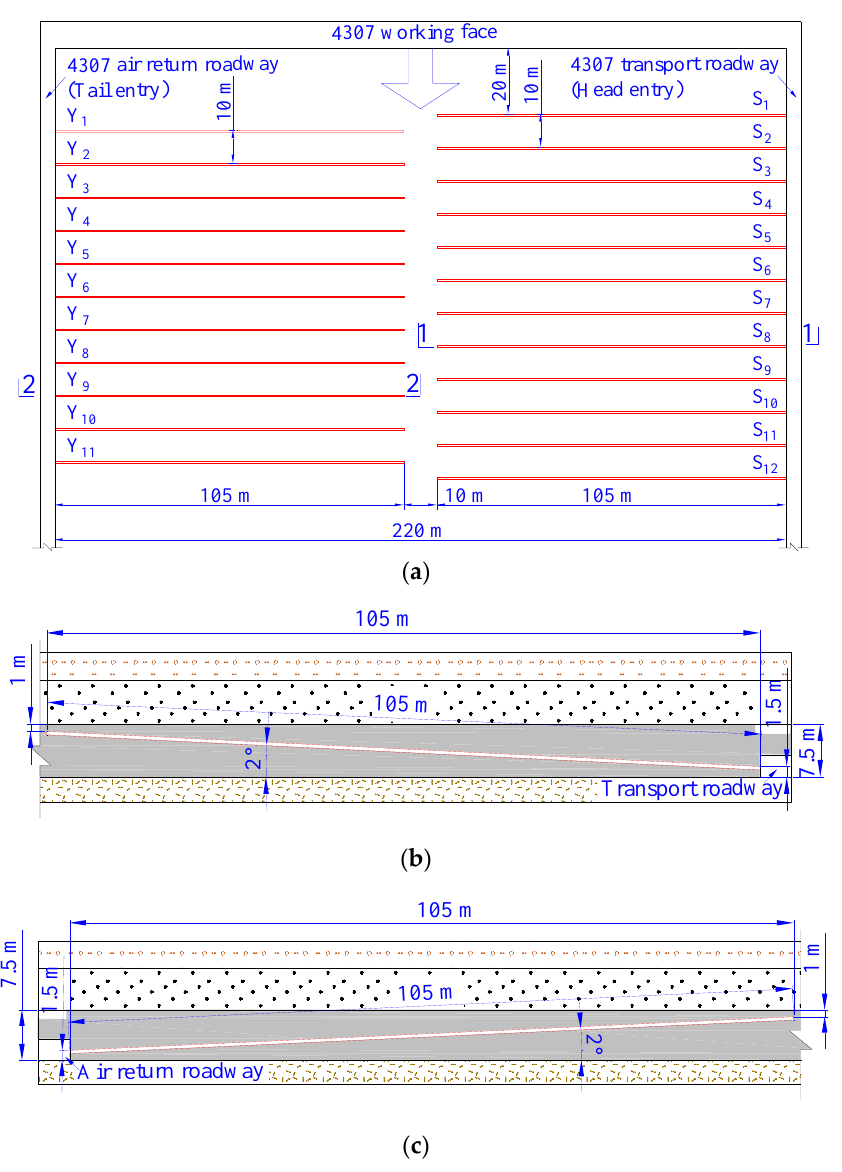
Figure 7. The layout of hydraulic fracturing boreholes: ( a ) plan view, ( b ) borehole at transport roadway (1-1 sectional view), and ( c ) borehole at air return roadway (2-2 sectional view).